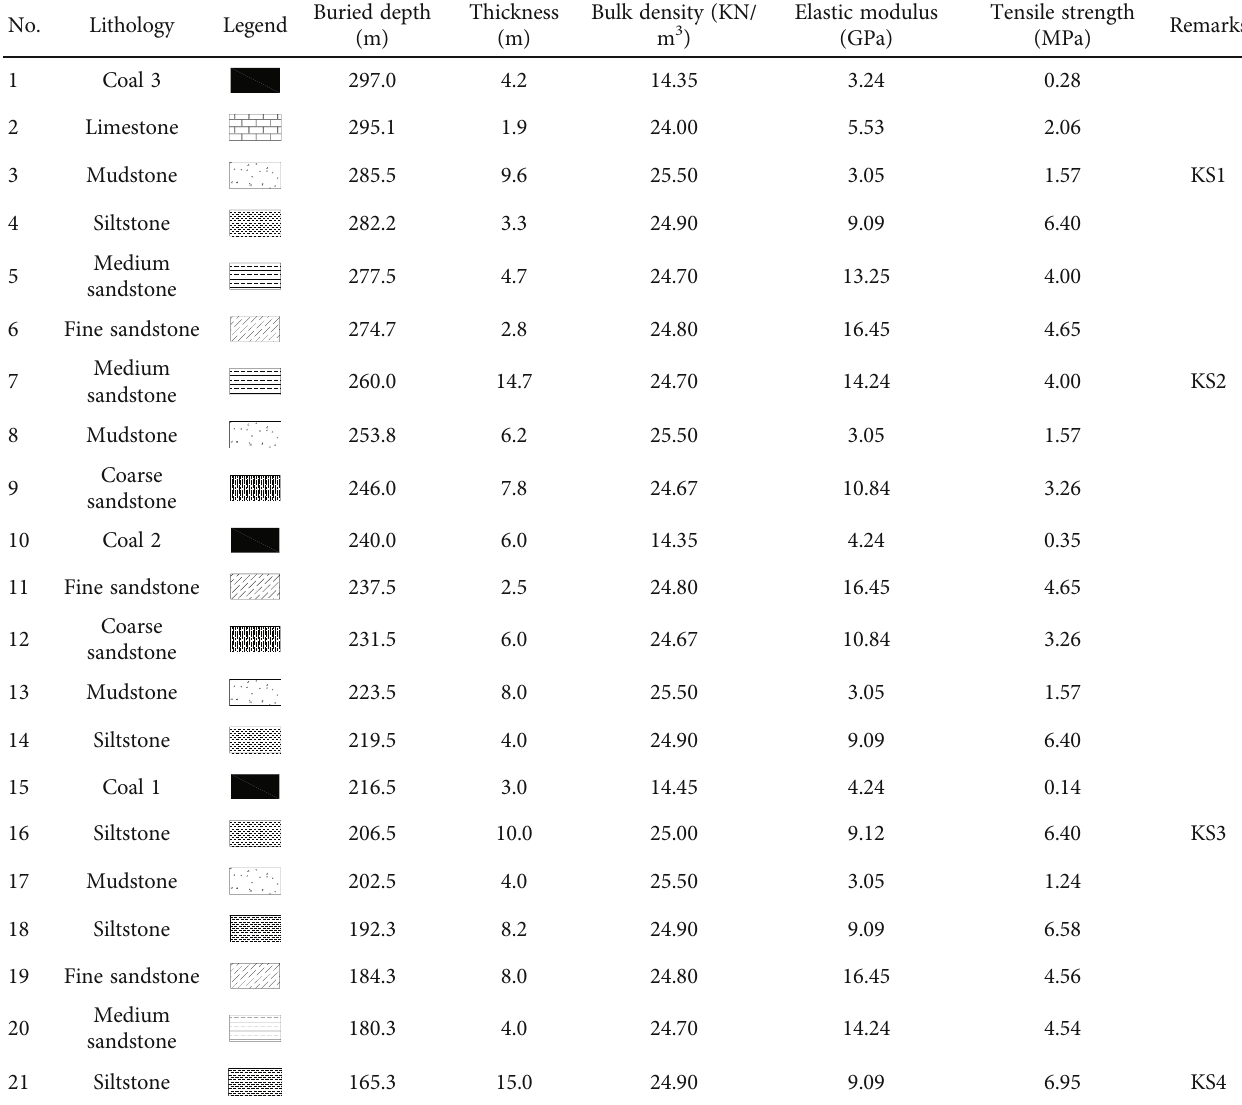
Table 1: Rock stratum